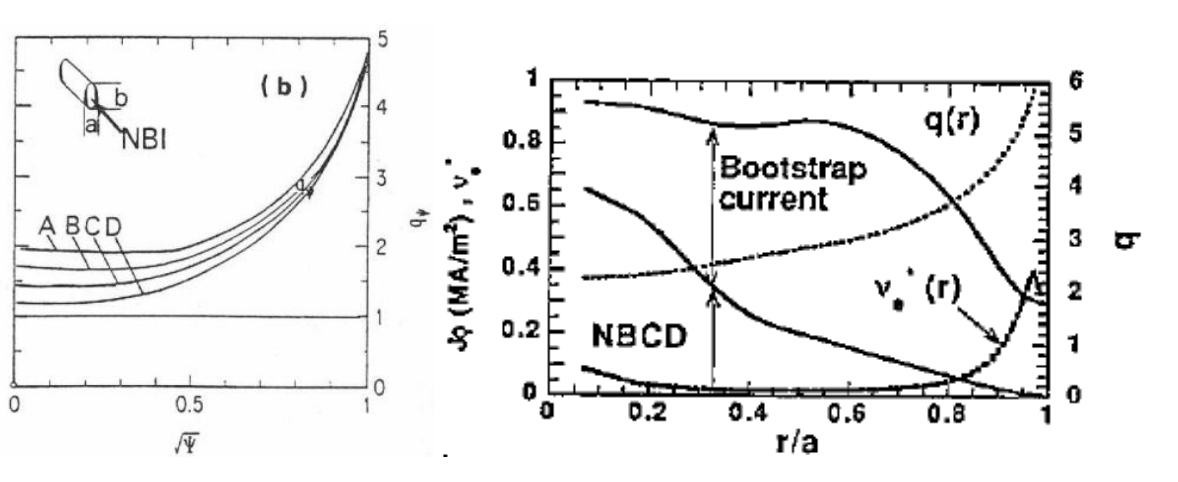
, l ) diagram in JT-60U showing the wide range of l eff i